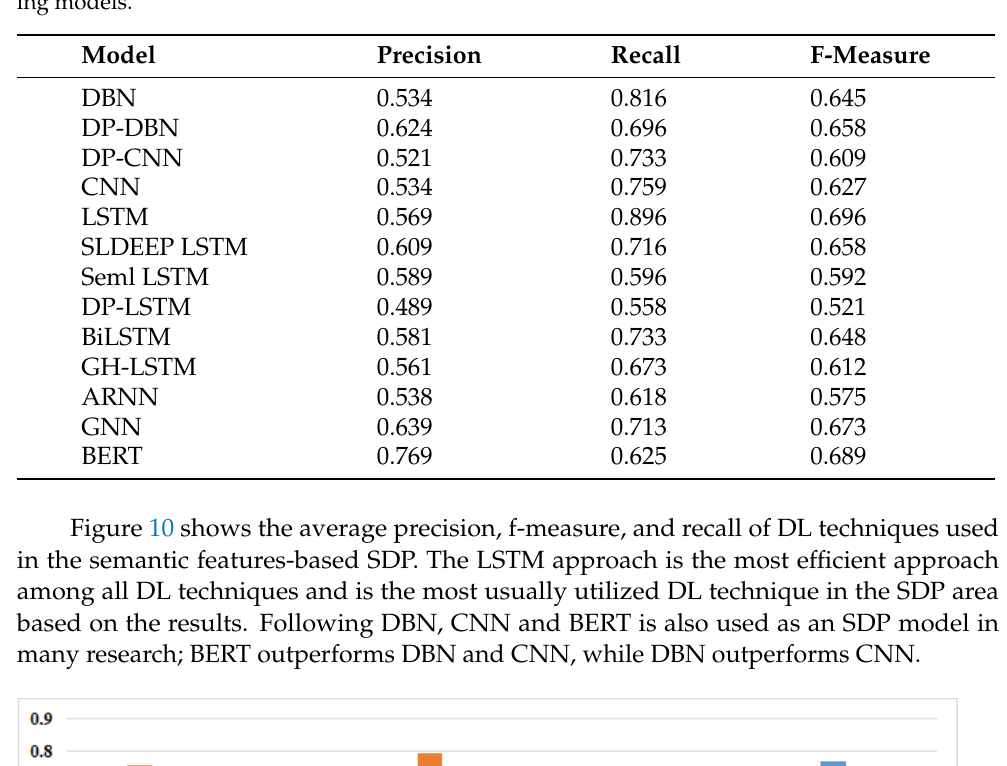
Table 6. Recall, Precision, and F-Measure values of semantic features based-SDP using deep learn- ing models.